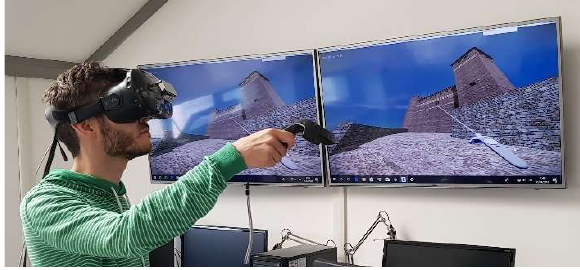
Figure 8. Immersive navigation through Autodesk